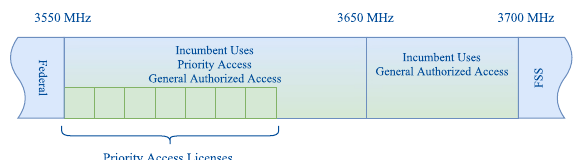
Figure 1. Tentative bandplan under the 3.5 GHz sharing framework.